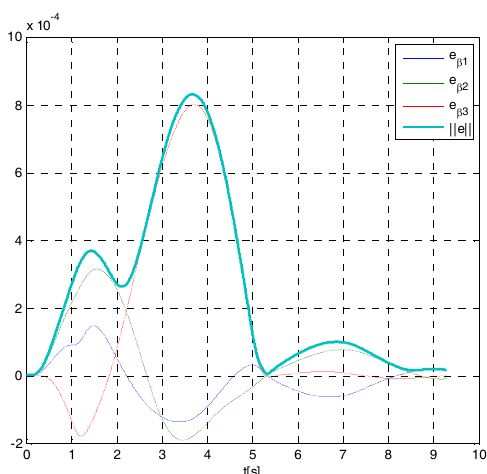
Appl. Sci. 2018 , 8 , x Figure 23. Time histories of the errors using the controller (70) with Figure 23. Time histories of the errors using the controller (70) with a